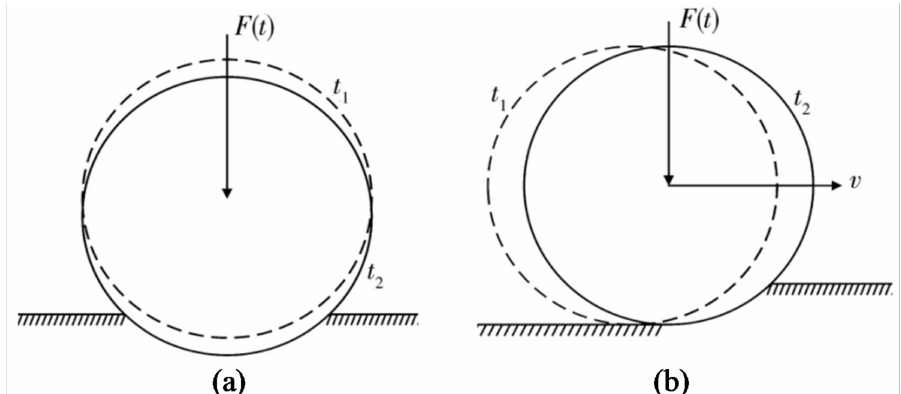
Figure 11. Vibration compaction in its original location and vibration compaction during driving.